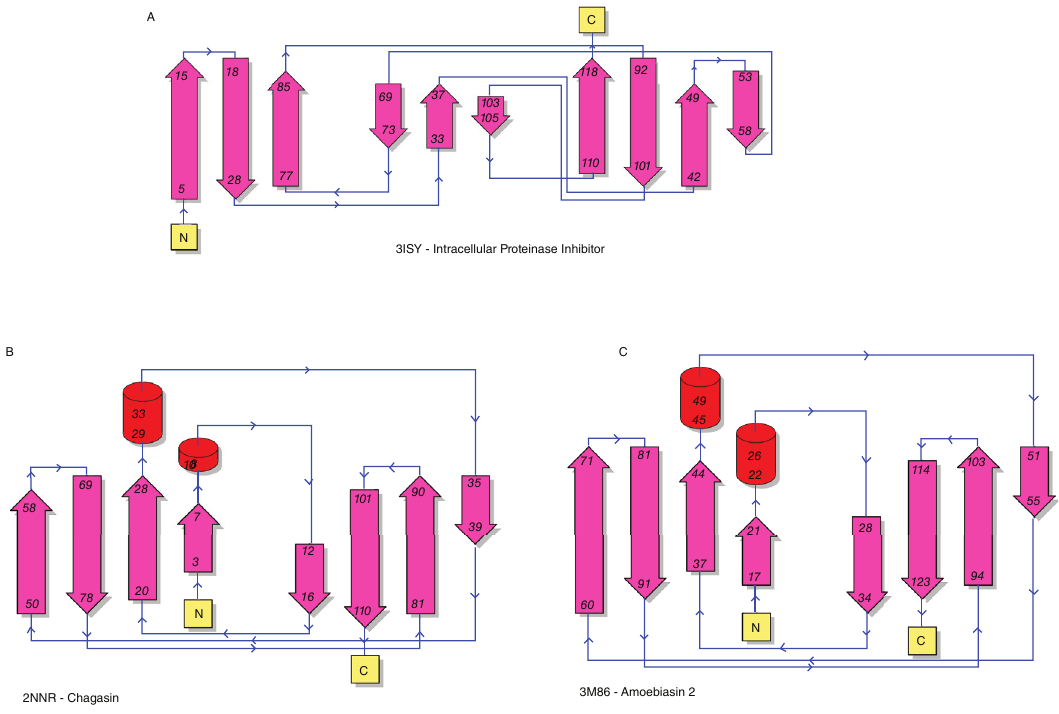
Figure 2. Secondary structure topologies of Intracellular Protease Inhibitor (IPI) and other peptidase inhibitors with an Ig-like fold. Topology diagrams are from PDBSum 43 . The labels indicate the PDB accession number and the protein